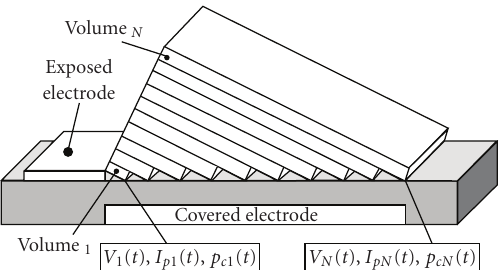
Figure 3: Subdivision of the air domain over the covered electrode into N volumes [19, 20].